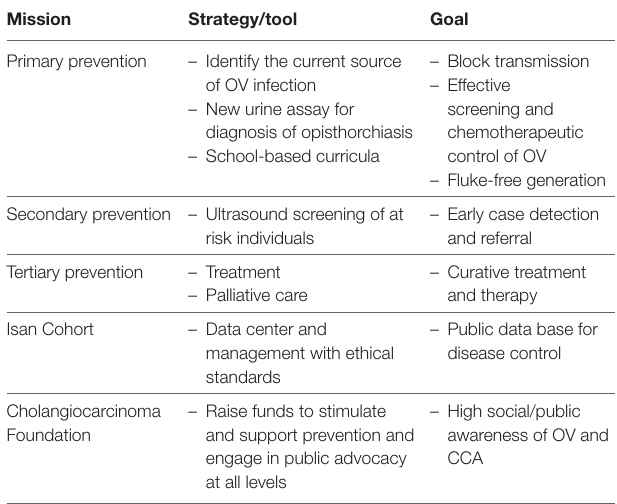
TABLe 1 | The missions of Cholangiocarcinoma Screening and Care Program and strategy to achieve specific goals.